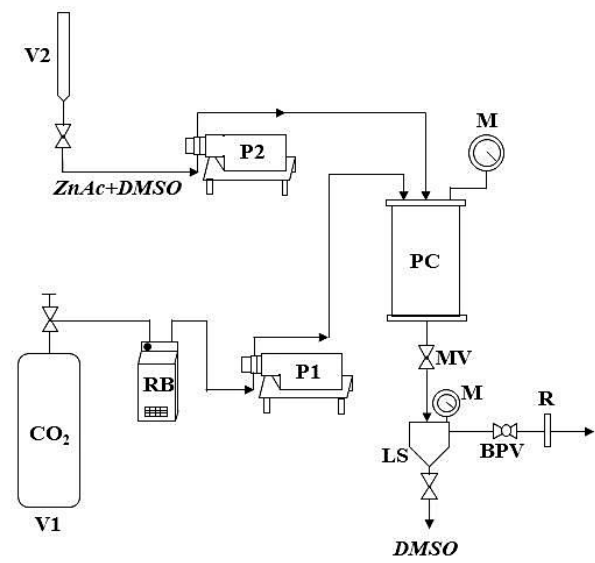
Figure 9. Schematic representation of supercritical antisolvent (SAS) apparatus. V1 is tank, V2 is burette, RB is refrigerating bath, P1 and P2 are pumps, PC is precipitation chamber, M is test gauge manometer, MV is micrometering valve, LS is collection vessel, BPV is backpressure valve, R is rotameter.